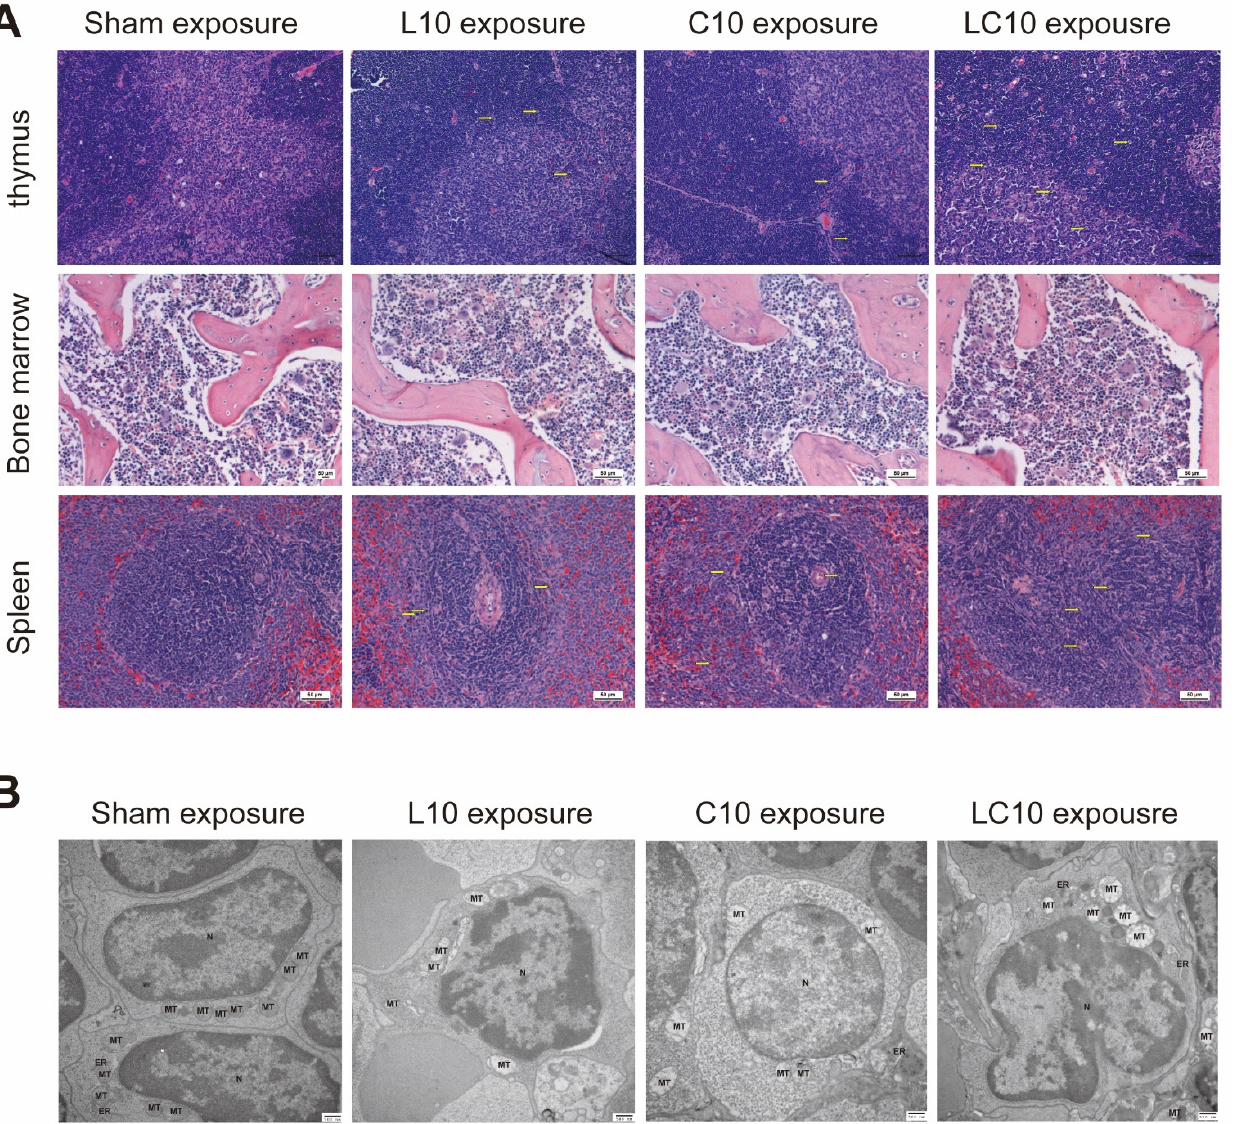
Figure 1. Microwave induced histopathological changes in thymus, bone marrow and spleen. 6–8-week male Wistar rats were exposed to microwaves with L band, C band and compound bands at the average power density of 10 mW/cm 2 . ( A ) At 6 h, 7 d, 14 d and 28 d after exposure, the rats were euthanized and the corresponding tissues were removed. The structure of the thymus, bone marrow and spleen was analyzed by hematoxylin–eosin (H&E) staining. The representative images from thymus, bone marrow and spleen at 7 d after microwave exposure were presented. The morphological changes were marked with yellow arrows. ( B ) For analyzing the ultrastructure of the spleen, the rats were euthanized and the spleens were removed at 7 d after exposure. The tissues were fixed in 2.5% glutaraldehyde and 1% osmium acid in sequence, the tissue blocks were processed with graded ethyl alcohols and embedded in EPON618. 70 nm thin slices were laid on copper mesh and then stained with heavy metals, uranyl acetate and lead citrate. The ultra-structures of the spleen were analyzed by transmission electron microscopy (TEM). N: nuclear; MT: mitochondria; ER: endoplasmic reticulum.